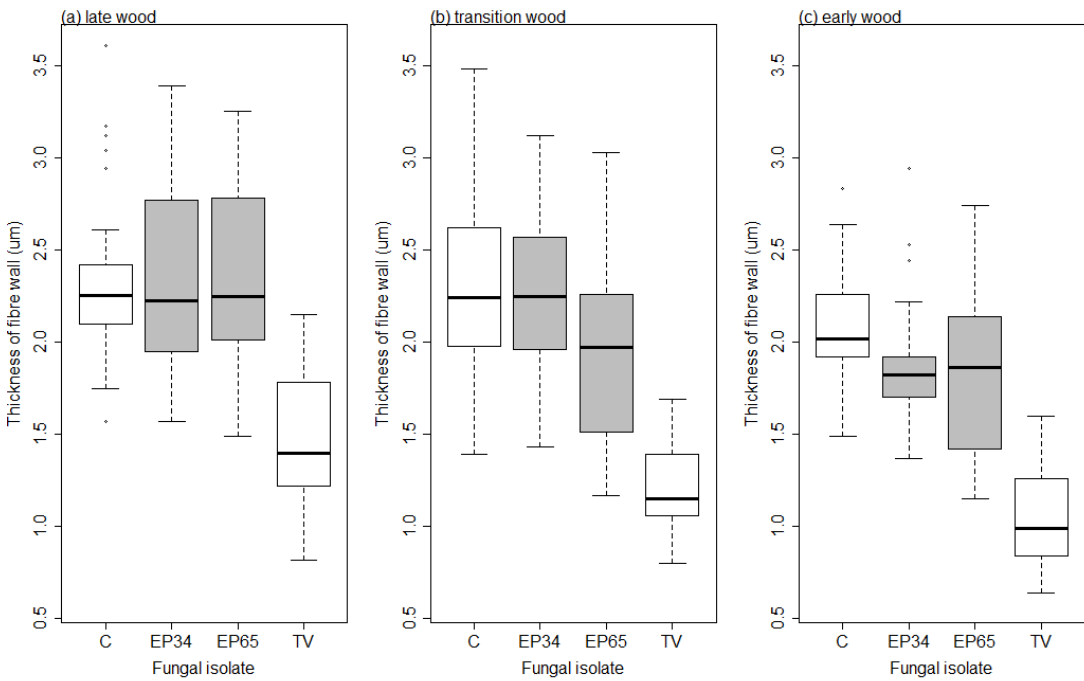
Figure 9. Fiber wall thickness ( µ m) in ( a ) late wood, ( b ) transition wood, and ( c ) early wood after exposure to different fungal isolates (see Table 1 for labels of isolates; boxes of E. parasitica isolates are grey). Boxplot represents minimum, first quartile (Q 1 ), median, third quartile (Q 3 ), and maximum value.